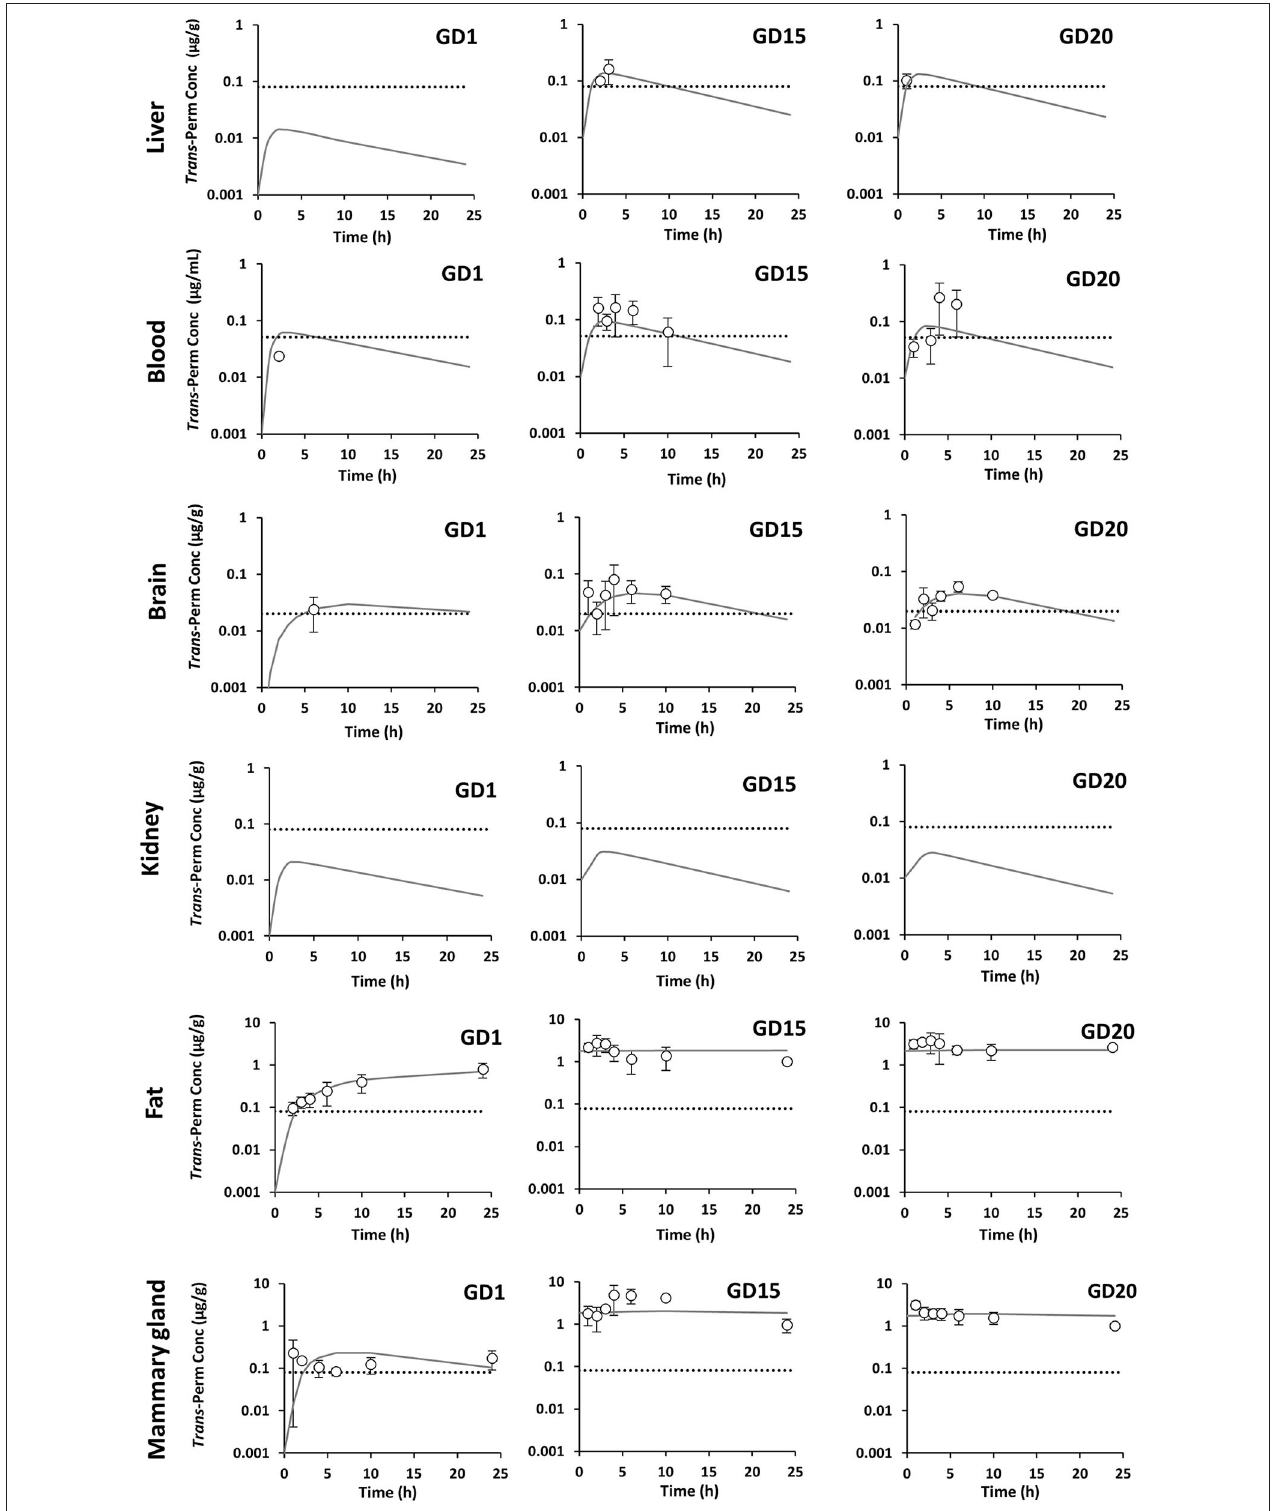
FIGURE 3 | Measured concentrations (dots) and toxicokinetic profiles estimated with the physiologically based pharmacokinetic model (solid line) of trans -permethrin in pregnant rats at GD1, GD15, and GD20. The gray dotted line stands for the limit of quantification.